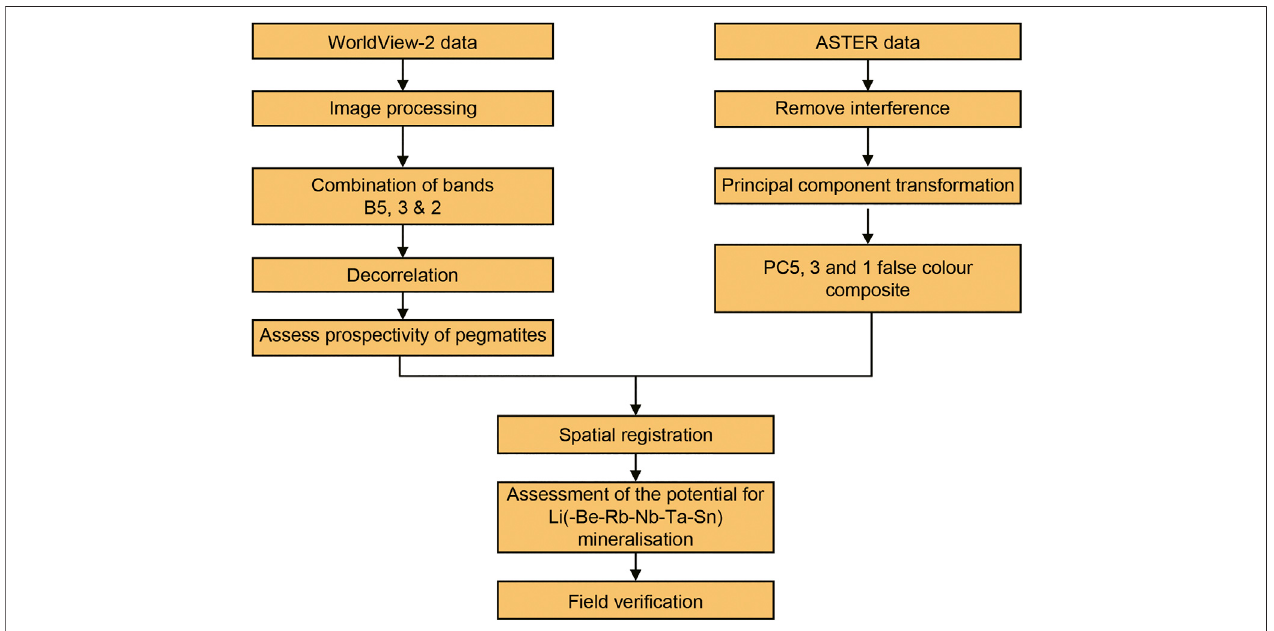
FIGURE 3 | Model showing the steps involved in interpreting remote sensing